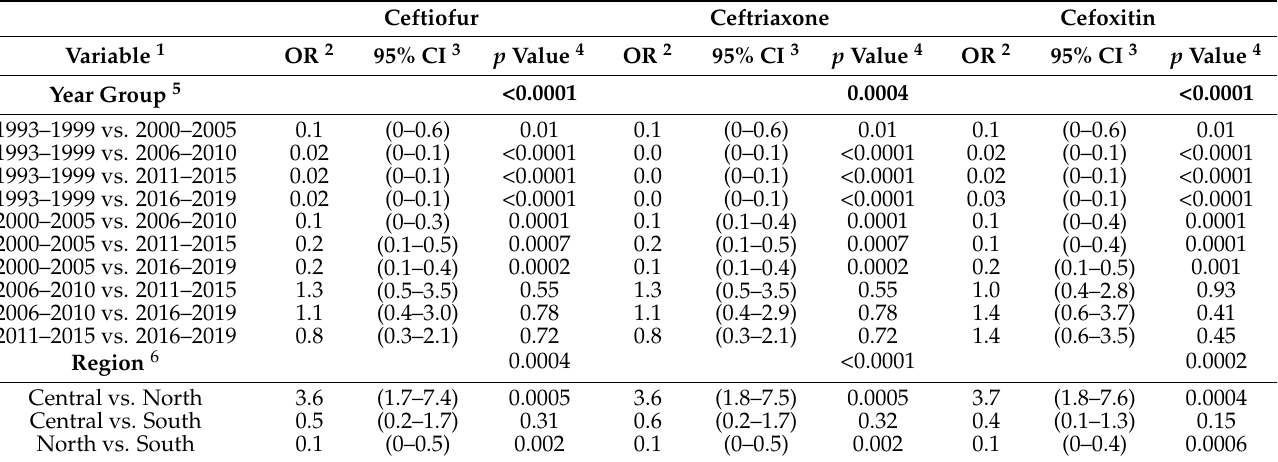
Table 5. Odds ratio for the effect of year group, region and animal age group for a S. Dublin classified as resistant for cephalosporin drugs in the NARMS panel. p values in bold indicates significant odds ratio associations.